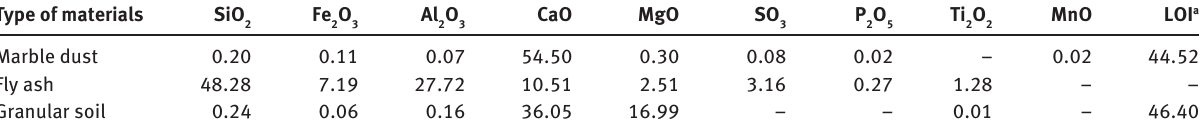
Table 2 Chemical compounds of used materials ( % ). a Loss of ignition.